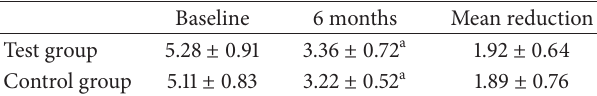
Table 1: Clinical Parameters at baseline and 6 months after treat-